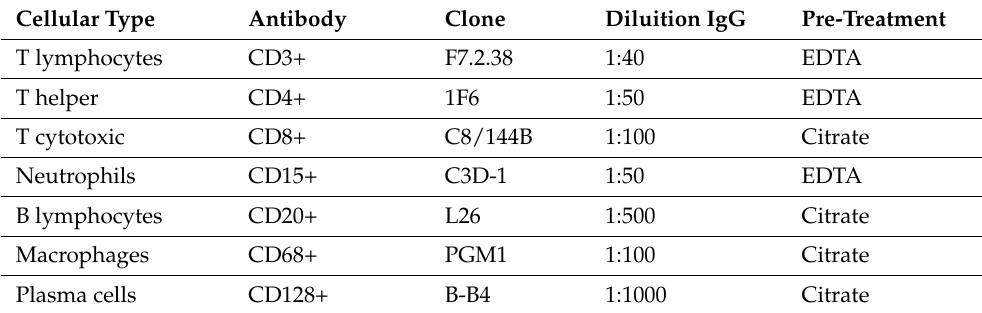
Table 1. Characteristics of the antibodies and relative cellular types chosen for immunohistochemistry. Cellular